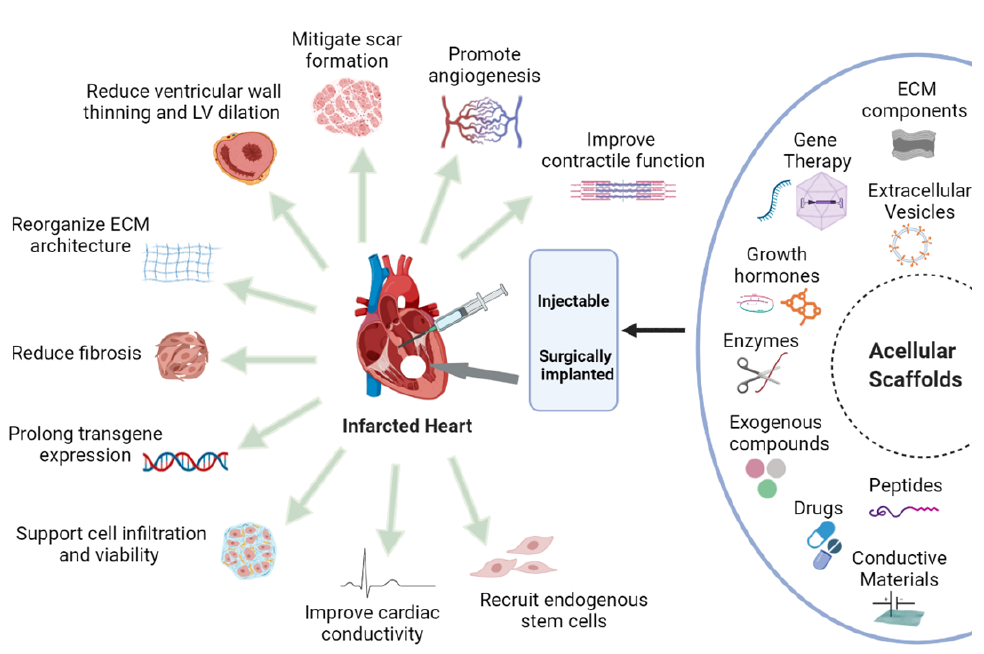
Figure 2. Acellular scaffold strategies applied in the infarcted heart to overcome myocardial infarction-induced LV remodelling. On the right , properties and functionalisations of several acellular scaffolds, that can be either injected or implanted on an infarcted heart, are illustrated. On the left , the biological effects obtained by various types of scaffold functionalisation on LV remodelling are shown. (ECM: Extracellular Matrix; LV: Left Ventricular).